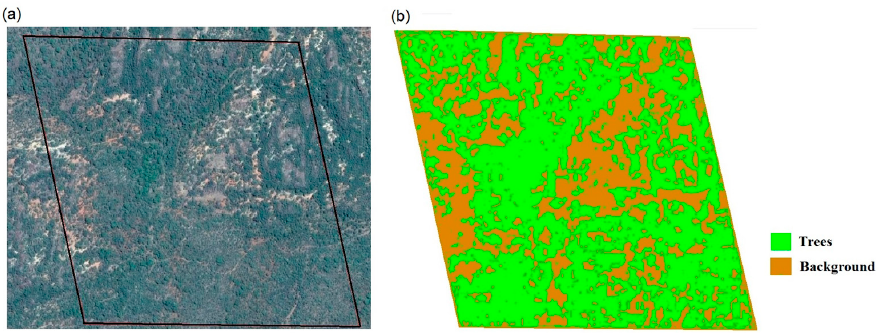
Figure 2. Tree cover (%) estimation using classification of high resolution Google Earth imagery ( a ) into tree and background classes ( b ). The polygon boundary is indicated in black on image ( a ).